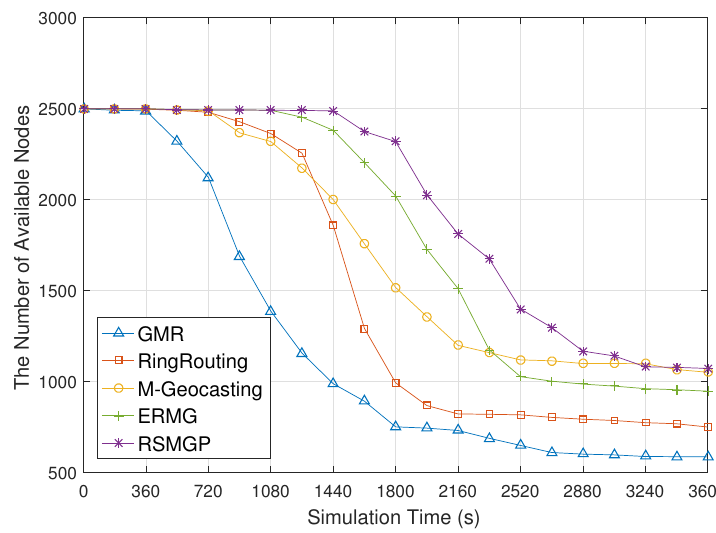
Figure 12. The number of available nodes according to elapsed simulation time.